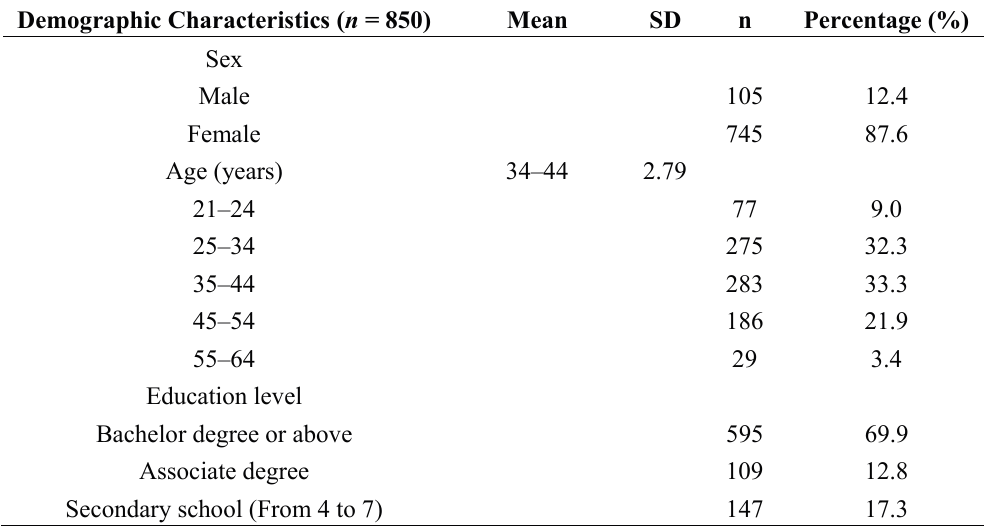
Table 1. Frequency distribution of respondents by socio-demographic characteristics and selected